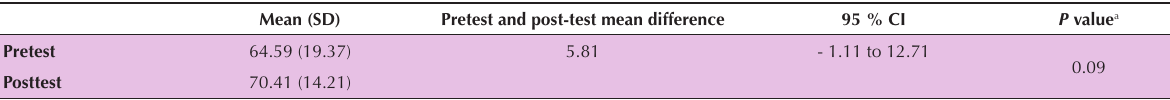
Table 1. Mean value of correctly answered questions in pretest and posttest for face to face group Mean (SD) Pretest and post-test mean difference 95 % CI P value a Pretest